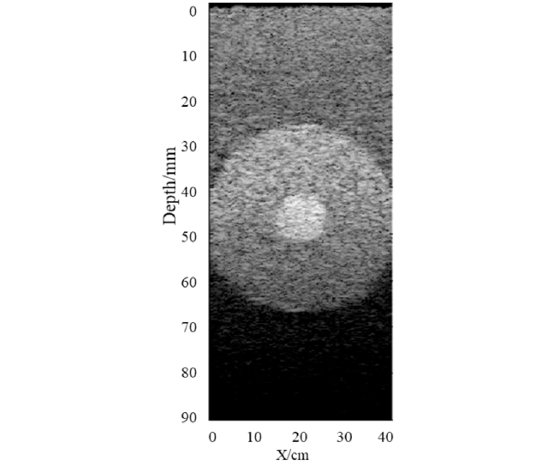
Figure 4. The original attenuation simulated phantom image without time gain compensation (TGC).